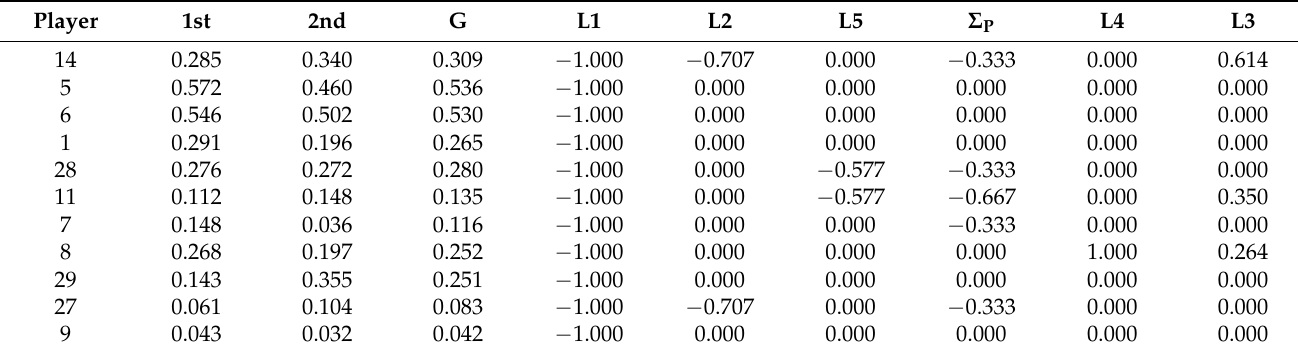
Table A10. Team B’s Eigenvector Centrality Matrix of values.